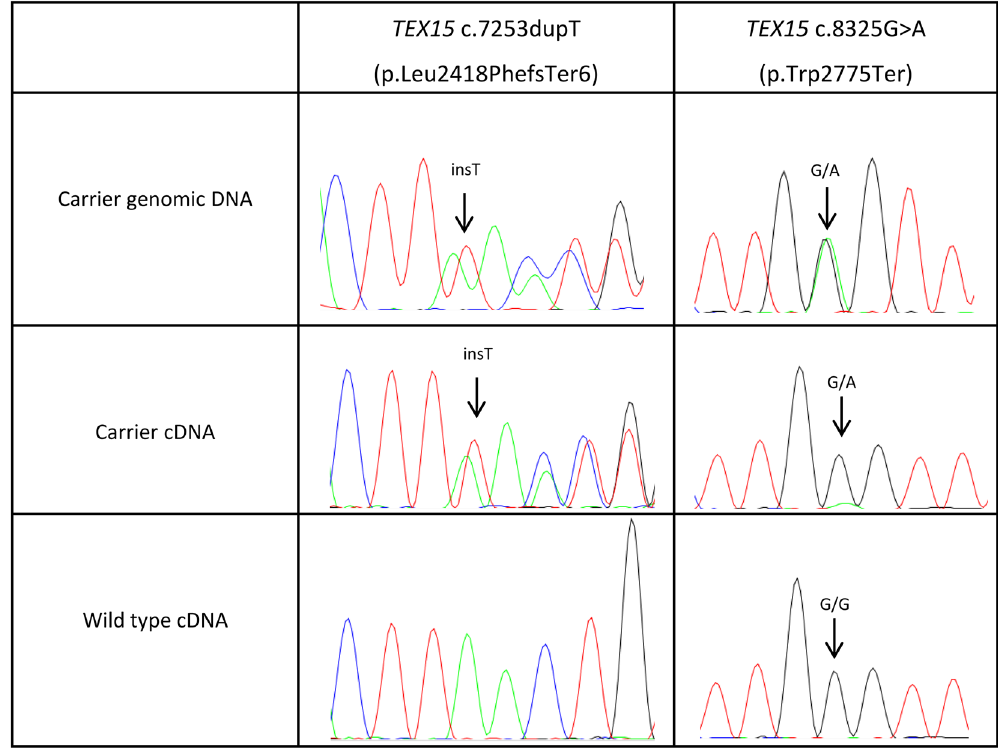
Figure 2. Sequencing of TEX15 c.7253dupT and c.8325G > A mutation sites at genomic DNA and cDNA